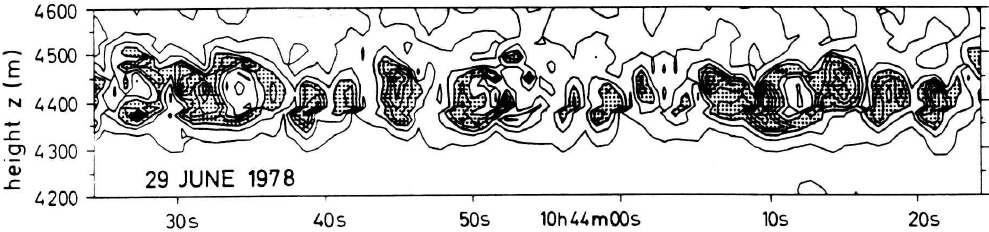
Fig. 5. Results of the application of deconvolution procedures to achieve sub-pulse-length resolution with a VHF radar. Cat’s-eye structures are